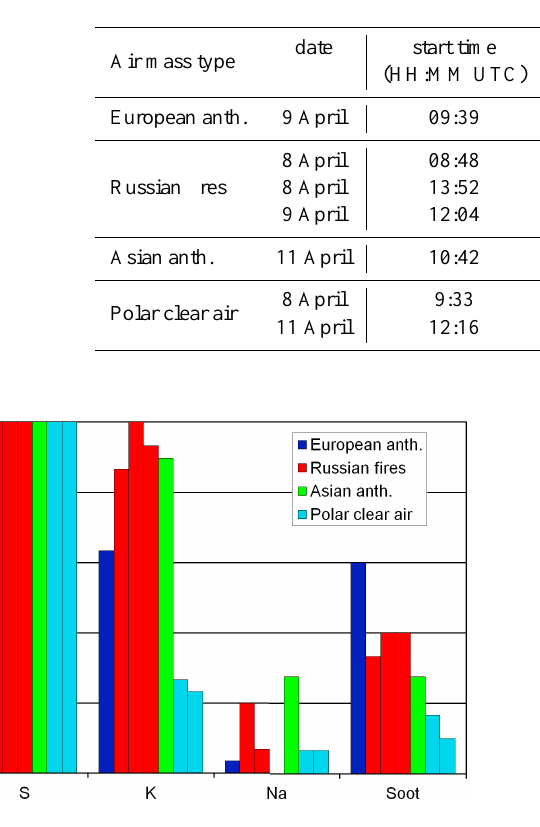
Table 7. TEM-EDX (submicron) and SEM-EDX (supermicron) samples of individual particles analysed for this study.